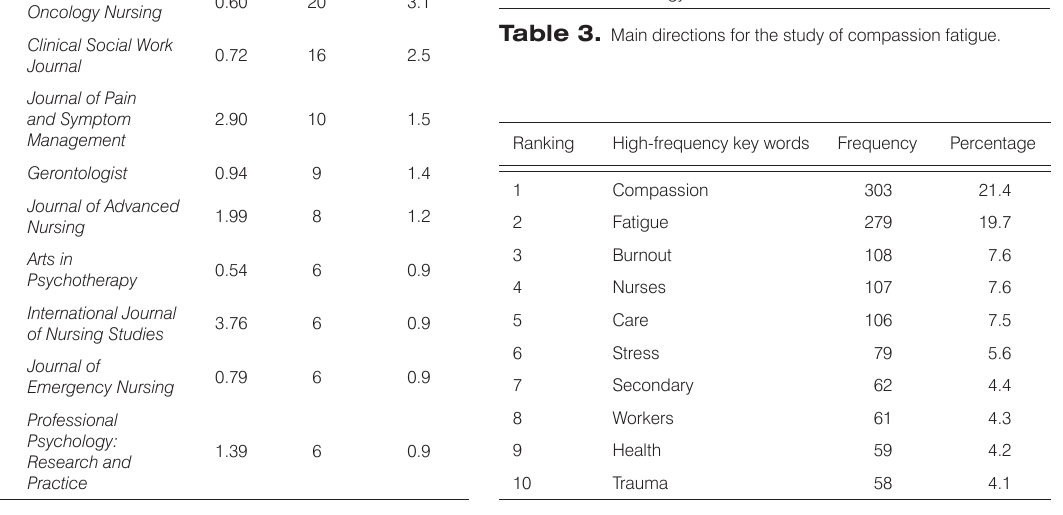
Table 2. The top ten journals of compassion fatigue.